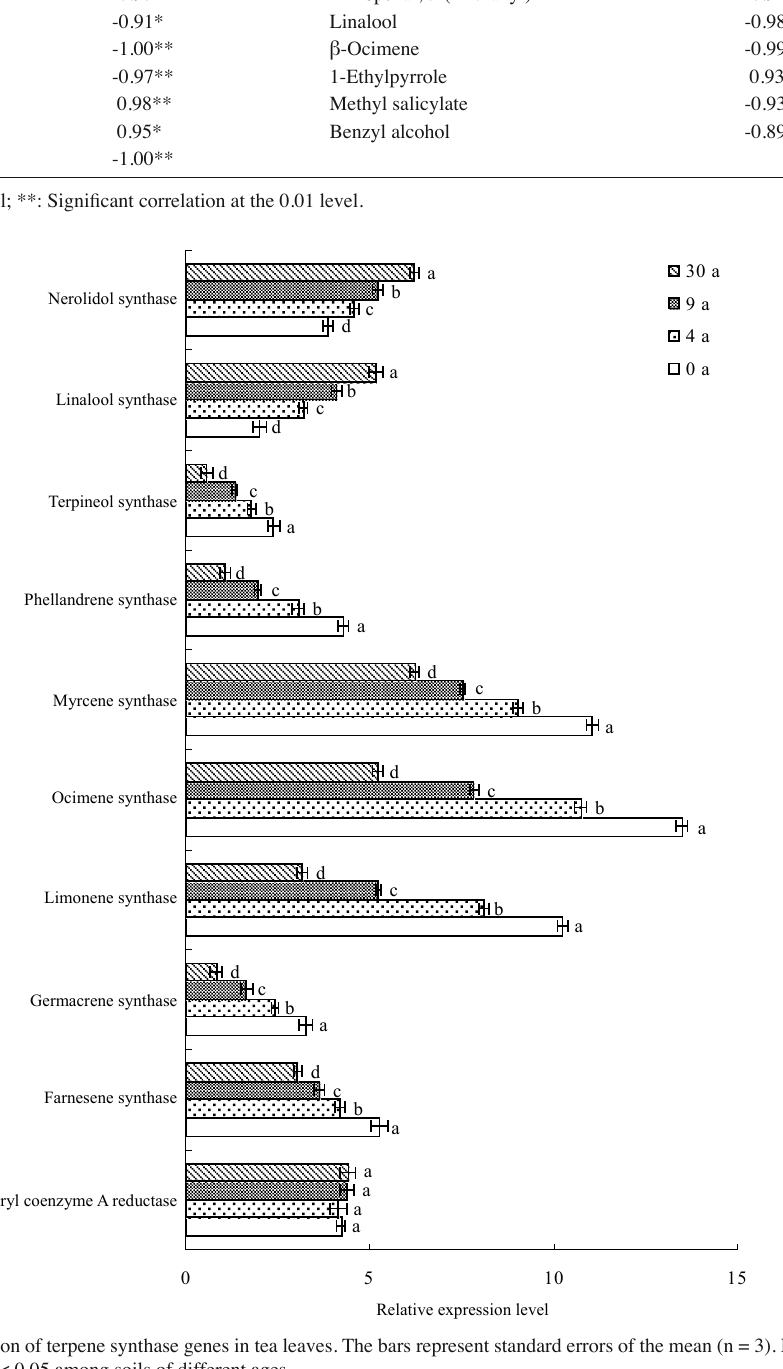
Fig. 3: Analysis of differential expression of terpene synthase genes in tea leaves. The bars represent standard errors of the mean (n = 3). Different letters indicate significant differences at p < 0.05 among soils of different ages.